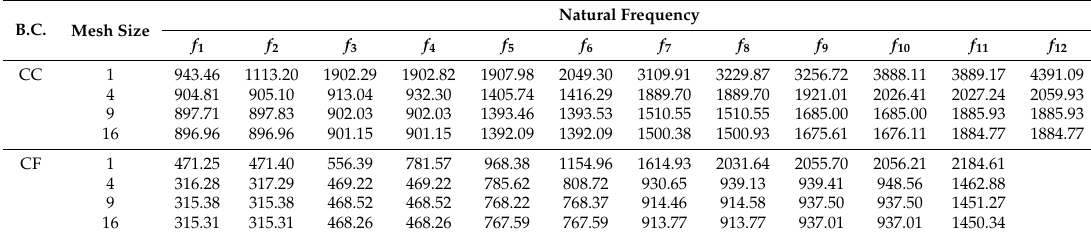
Table 4. Convergence of natural frequencies of cylinder with constant thickness.